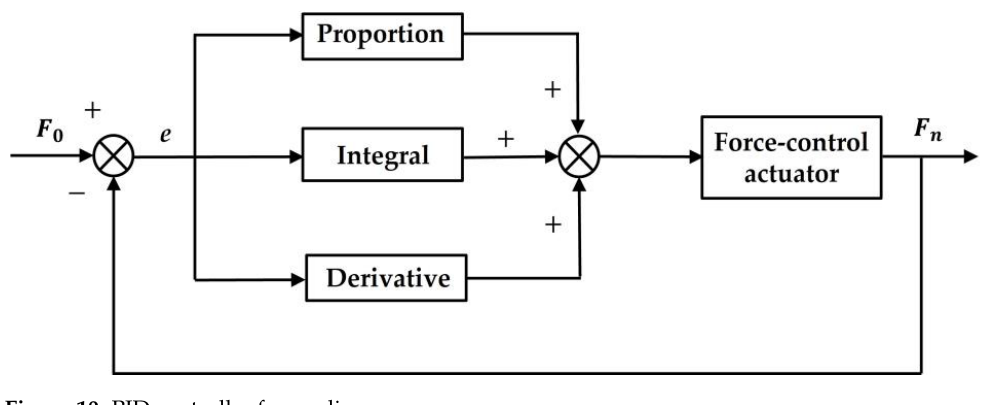
Figure 10. PID controller frame diagram.